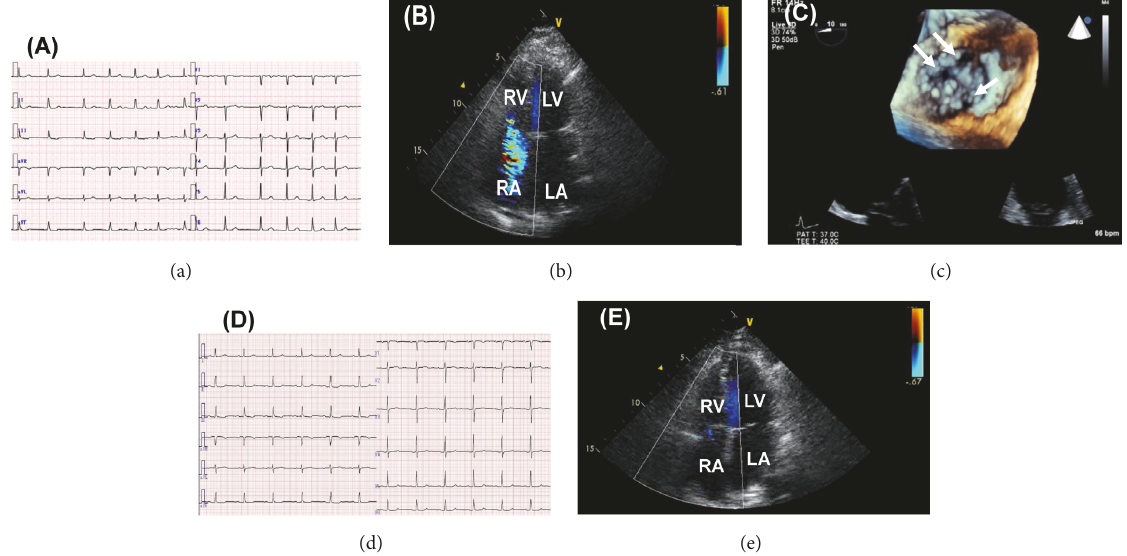
Figure 1: Twelve-lead electrocardiogram (ECG) demonstrating AF rhythm on admission (a) but demonstrating normal sinus rhythm two months after annuloplasty (d). Doppler echocardiography showing severe TR due to insufficient leaflet coaptation on admission (b) but showingtheimprovementofTRafterannuloplasty(e)intheapicalviewtractatsystole.Three-dimensionaltransesophagealechocardiography showing coaptation defect (arrows) (c). RV: right ventricular; LV: left ventricular; RA: right atrium; LA: left atrium.